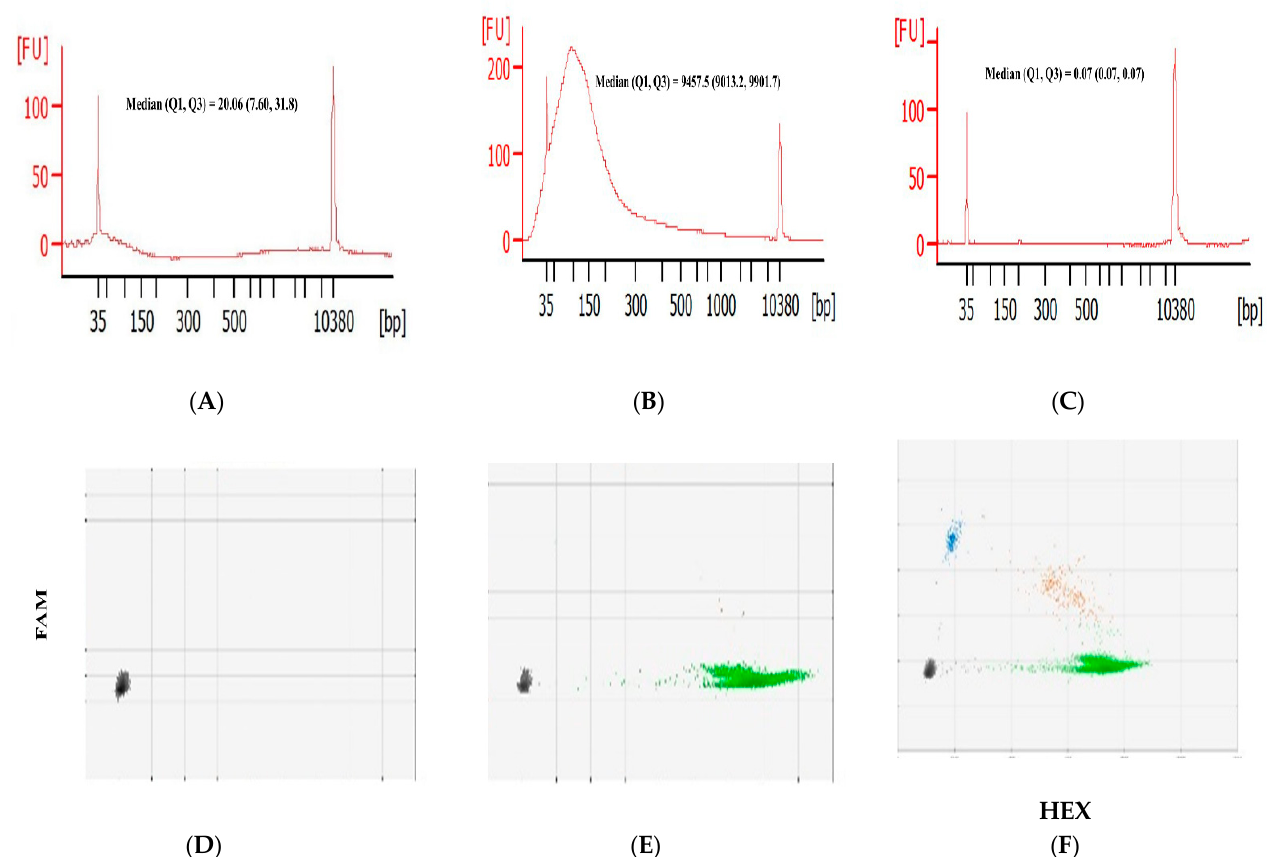
Figure 2. Size distribution of DNA fragments and histograms of KRAS mutations in bile ( A ), tissue ( B ) and plasma ( C ). Numbers indicate the sizes of the predominant DNAs in the samples. A 2D plots of the results of ddPCR KRAS multiplex assays applied to bile ctDNA in the NTC ( D ), control ( E ), and BTC samples with KRAS mutations ( F ). Black cluster on the plot represents negative droplets; green cluster represents droplets that were positive for wild-type DNA only; blue cluster represents droplets that were positive for mutant DNA only; and orange cluster represents droplets that were positive for both mutant and wild-type DNA. All panels show FAM amplitudes of up to 12,000 and HEX amplitudes of up to 12,000.